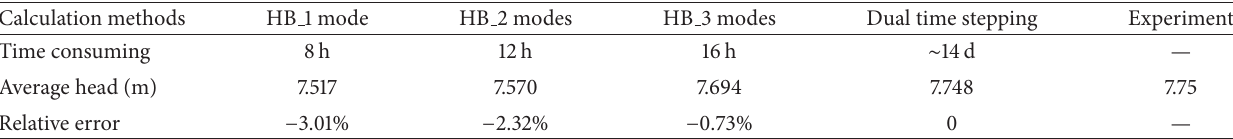
Table 2: The predicted head for different harmonics.